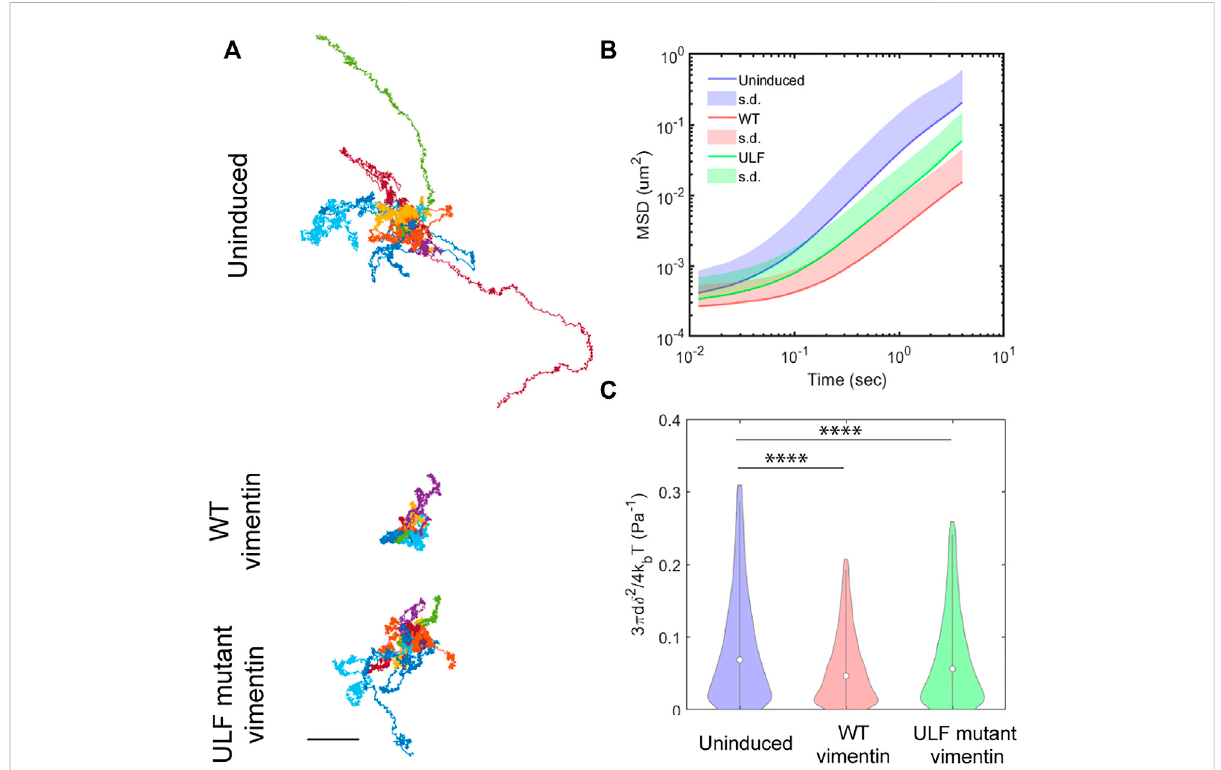
Vimentin expression reduces intracellular motion. (A) Trajectories of particles measured in 10 different cells in each group, from videos taken every12 msover20 stimeintervals.Scalebar,0.5 µm. (B) MeanSquareDisplacement(MSD)ofparticles. (C) Complianceofcytoplasm. δ 2